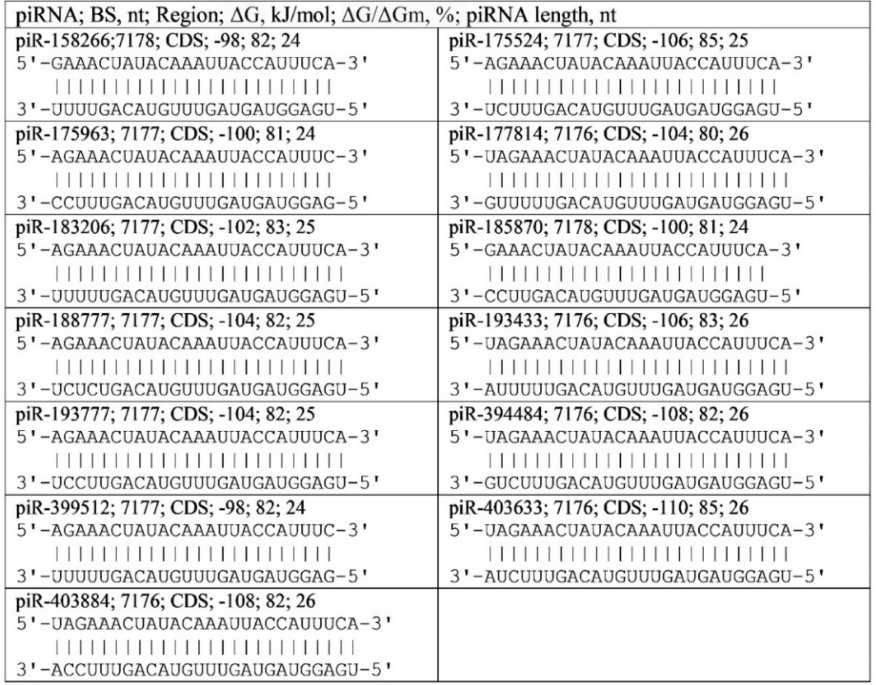
Figure 1. The characteristics of piRNAs and gRNA interactions involving canonical and non-canonical nucleotide pairs. The schemes indicate: the name of the piRNA; the start of the piRNA binding site; the region where the piRNA binding site is located in gRNA; the free energy of interaction of piRNA with gRNA ( ∆ G); the ratio ∆ G/ ∆ Gm (%), where ∆ Gm equals the free energy of piRNA binding with its fully complementary nucleotide sequence; the length of